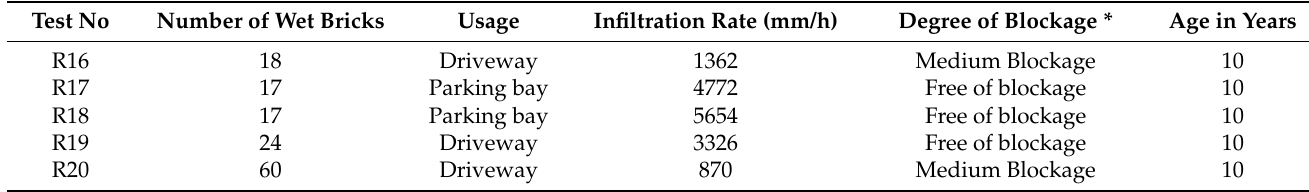
Table 2. Tests at different locations in Newington School car